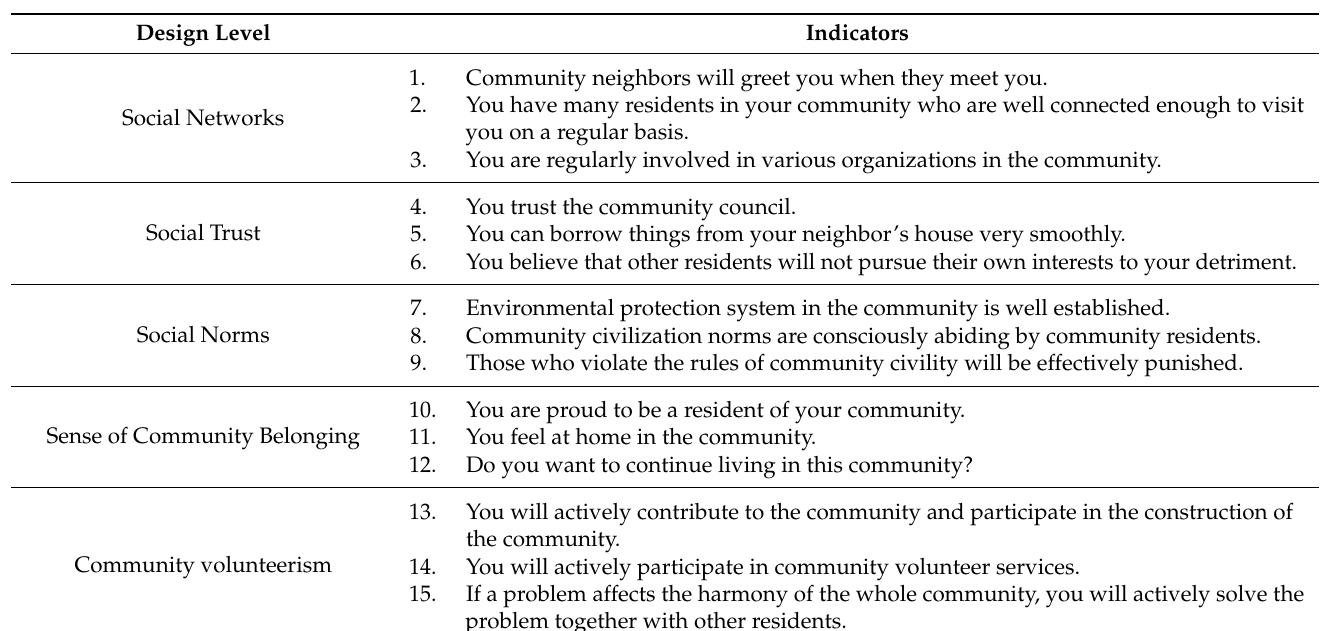
Table 3. Social capital evaluation